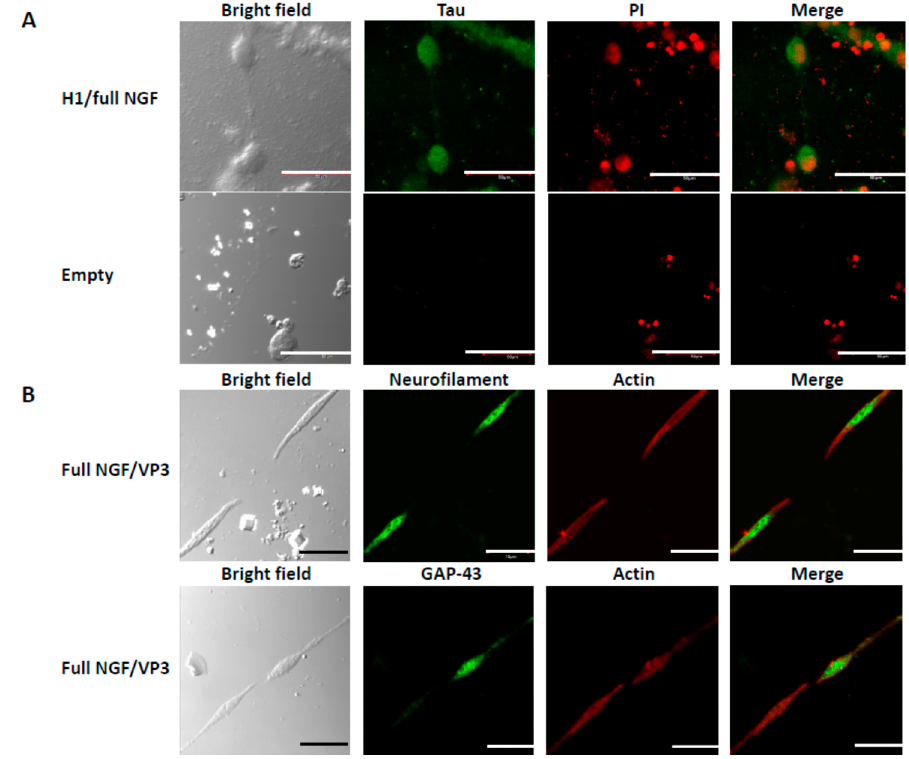
Figure 4. Expression of neural differential markers in the aligned PC12 cells. ( A ) Expression of tau. PC12 cells were incubated with H1-tagged pfNGF (H1/full NGF) or empty PODS nanoparticles (Empty). Expression of tau and nuclei were detected by immunofluorescence cytochemistry and propidium iodide (PI) staining. ( B ) Expression of neurofilament, GAP-43 and actin. PC12 cells were incubated with VP3-tagged pfNGF (Full NGF/VP3). Each protein was detected by immunofluorescence cytochemistry. Scale bars, 50 μ m.